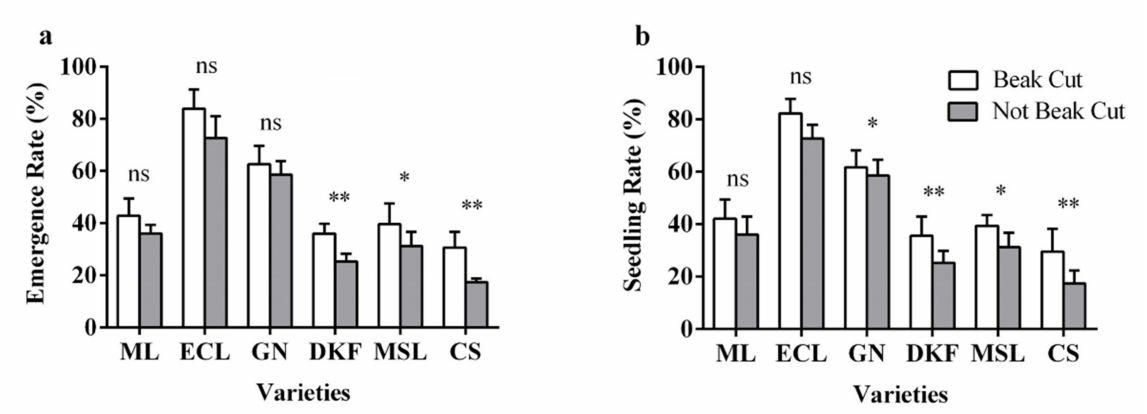
Figure 7. Effect of beak cutting treatment on seedling characteristics of six tested varieties: ( a ) influence of beak cutting treatment on emergence rate of tested varieties, and ( b ) influence of beak cutting treatment on seedling rate of tested varieties. Data in this figure were tested by Student’s t test; * p < 0.05 and ** p < 0.01 represent significant differences between treatments, and ns indicates not significant. ML, ECL, GN, DKF, MSL, and CS represent varieties of Meili, Ecolly, Garanior, Dunkelfelder, Marselan, and Cabernet Sauvignon.